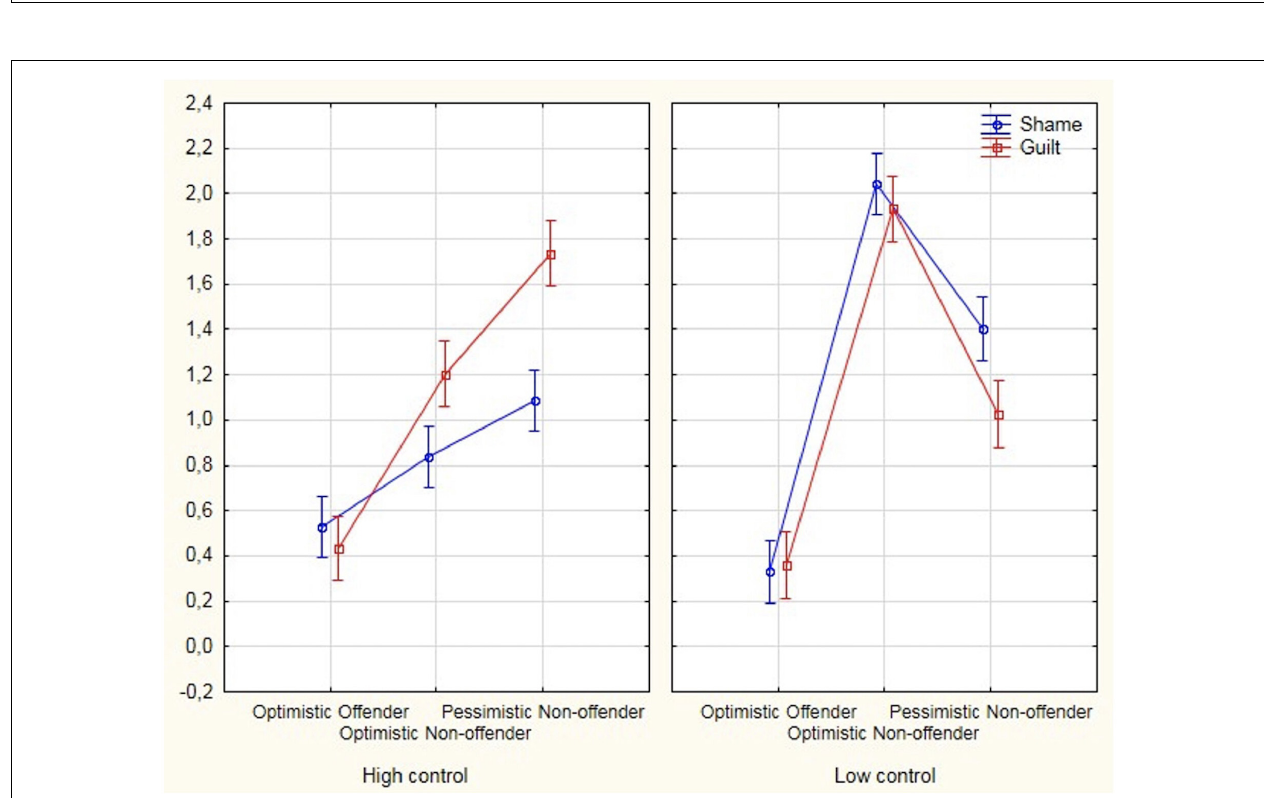
FIGURE 1 | Effect of interaction between (upward and downward) counterfactual factor on study group and task condition.